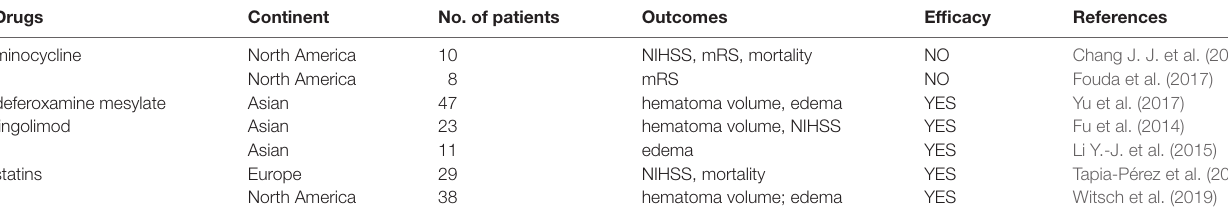
TABLE 4 | Clinical researches on microglial regulation for ICH